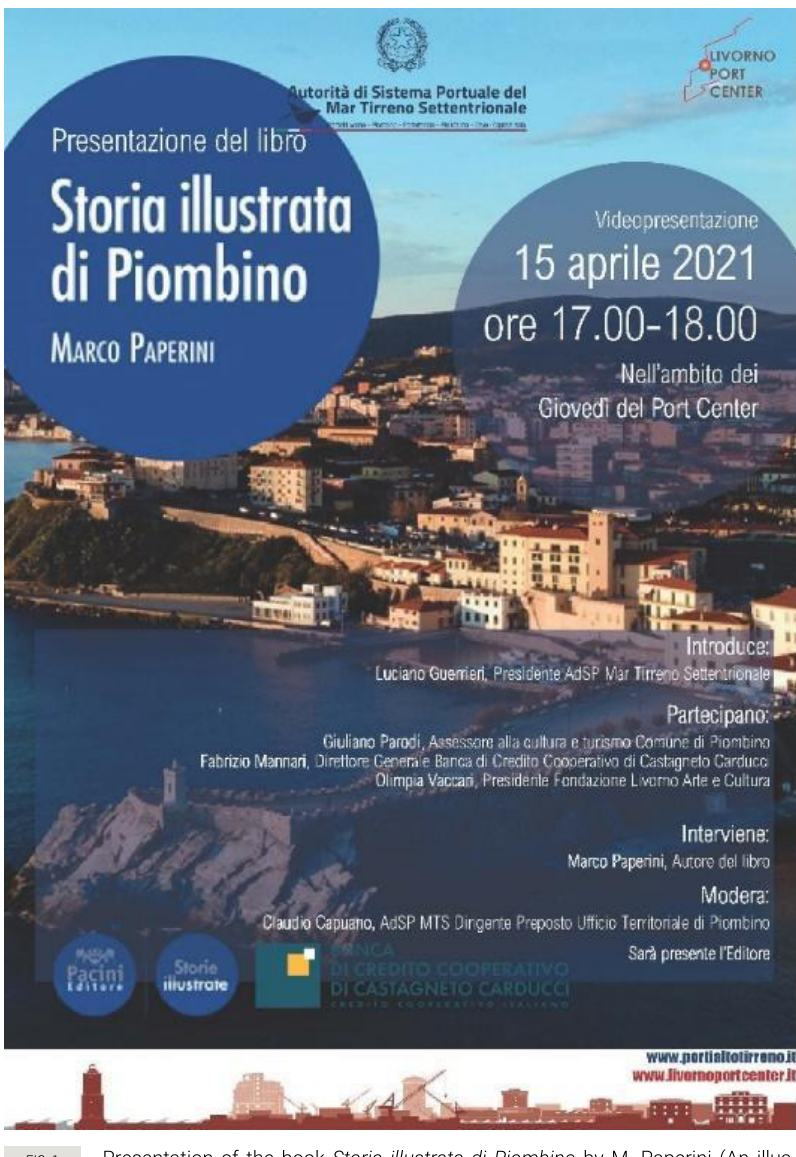
FIG. 1 Presentation of the book Storia illustrata di Piombino by M. Paperini (An illus- trated history of Piombino), 15 April 2021- (Graphic material produced by the North Tyrrhenian Port Network